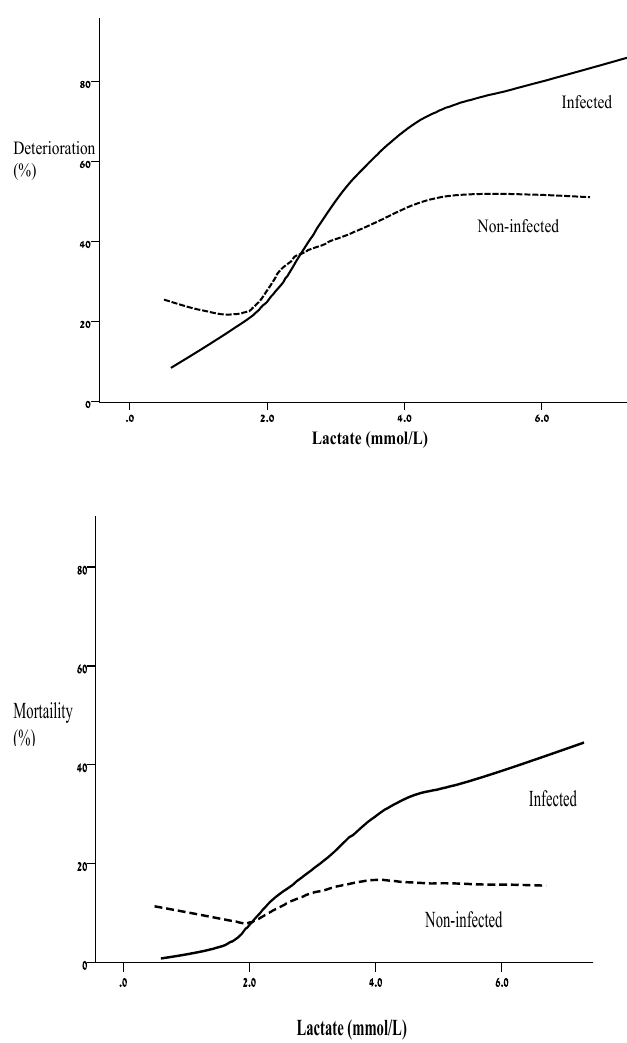
Figure 2a. LOESS graph with adjusted probability for deterioration